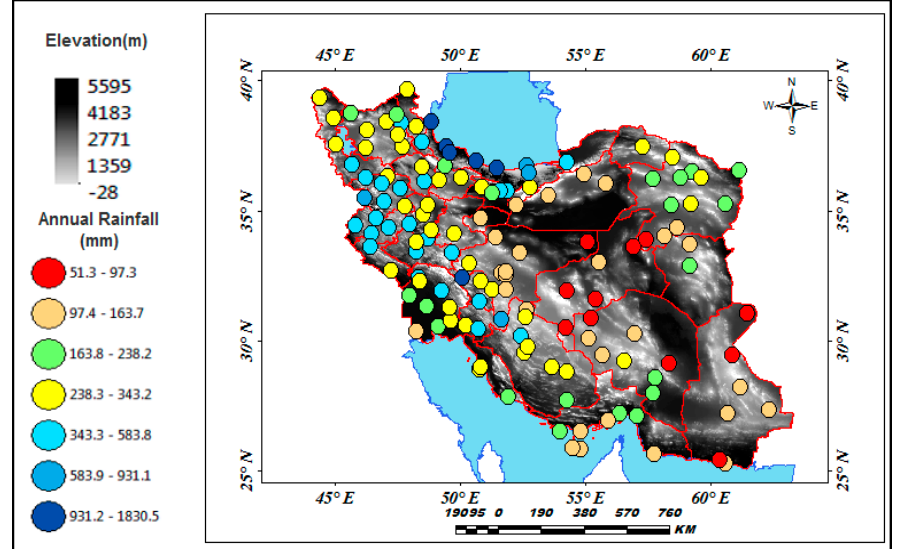
Figure 2. DEM and rainfall distribution in Iran.